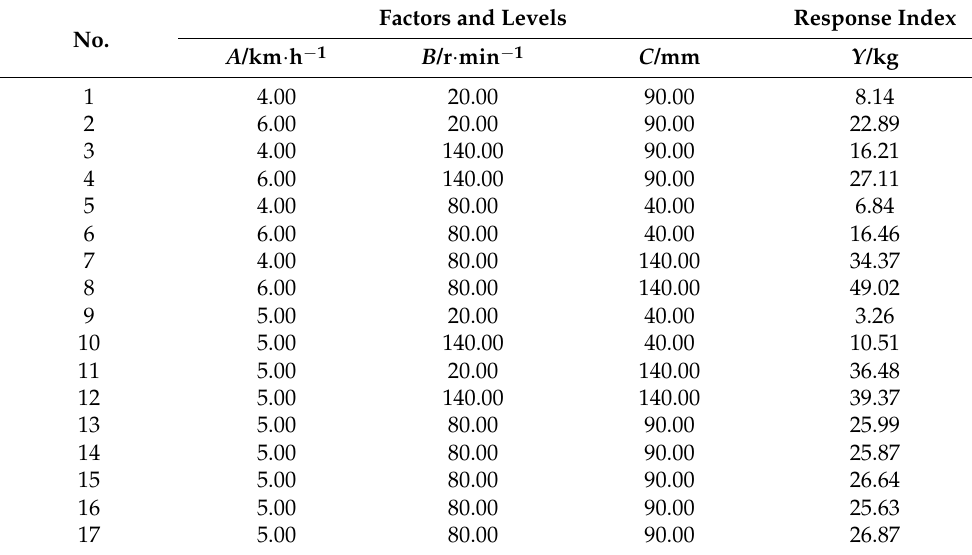
Table 3. Experimental design and